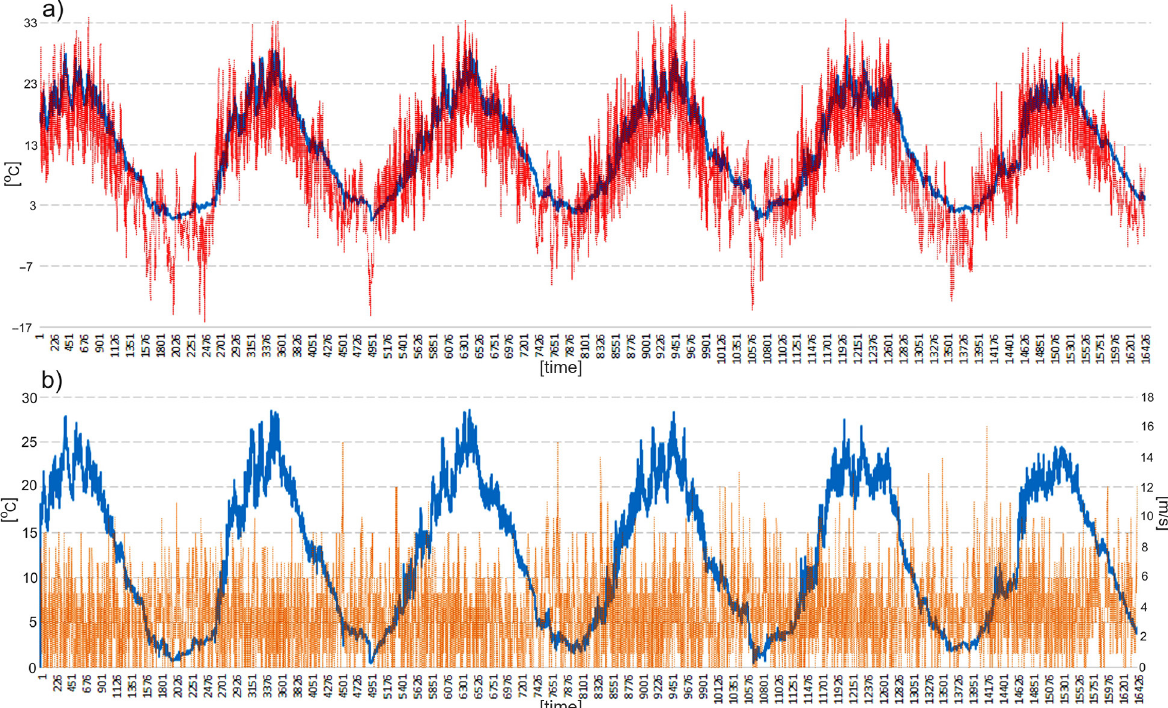
Fig. 7. Course of water temperature (blue lines) in Lake Kierskie and a) air temperature (red line) and b) wind speed (orange line) for station Poznań-ławica in 3-hours interval (May 2012–january